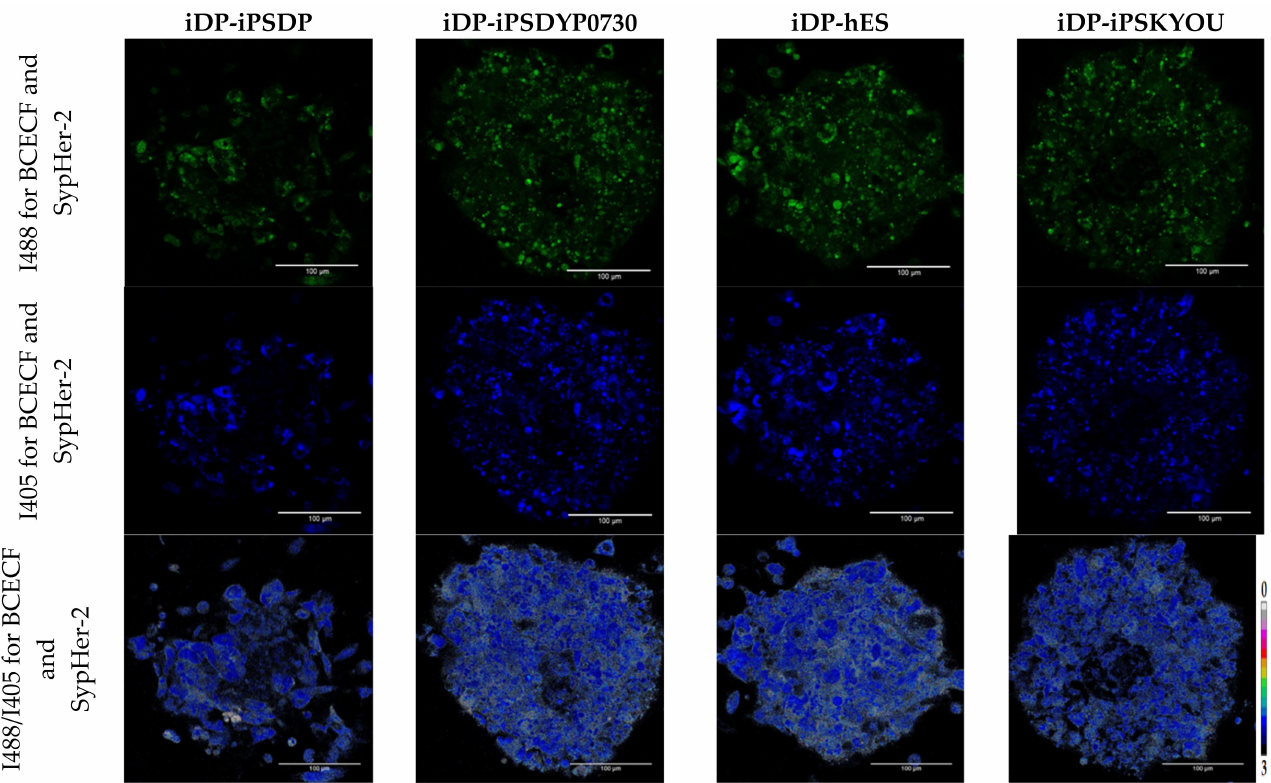
Figure 11. Analysis of the intracellular pH iDP spheroids: Images of the fluorescence intensity of SypHer-2 and BCECF when excited at a wavelength of 488 nm and 405 nm and images of the fluorescence intensity ratio I488/I405 in iDP spheroids. Excitation of SypHer-2 and BCECF fluorescence at 488 and 405 nm, fluorescence detection at 500–550 nm. Images size is 213 × 213 µ m, the scale length in all pictures is 100 µ